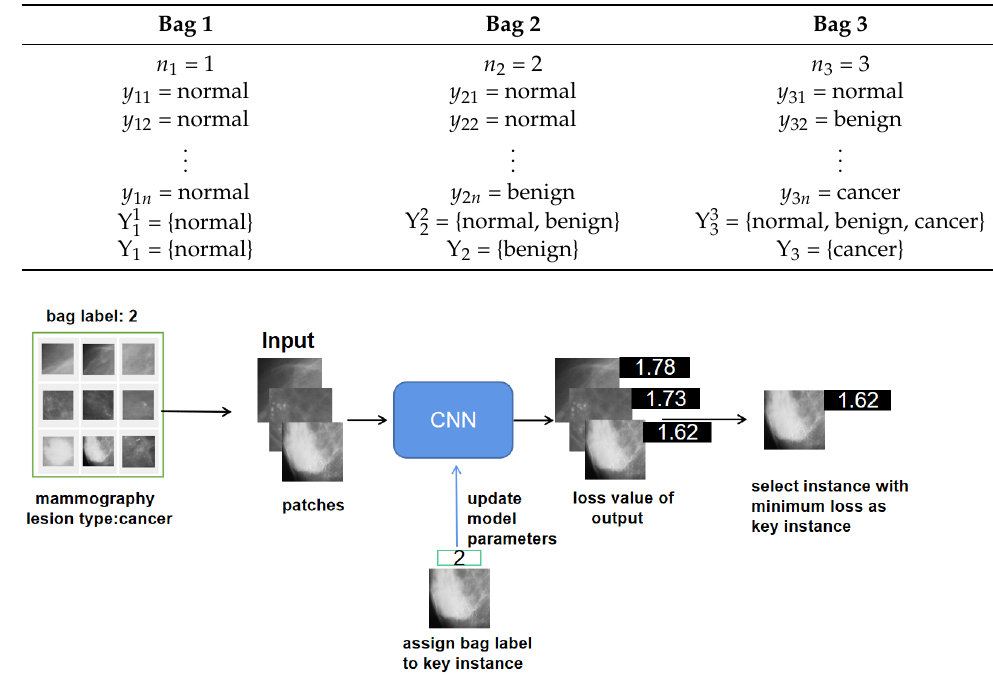
Figure 2. Overall model structure of OOMIL. Mammograms are split into patches, and then fed to the model to select the minimum-loss patch. The key instance-assigned bag labels participate in model training.